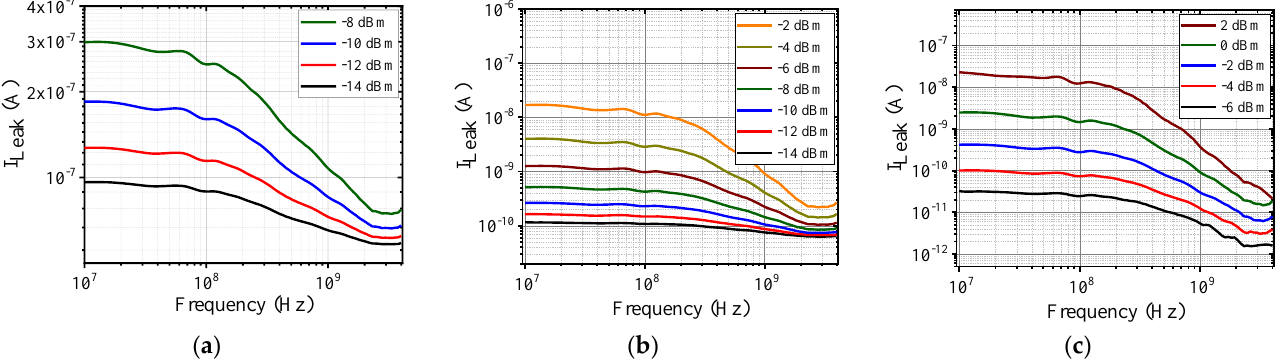
Figure 8. The measured leakage current due to a NMOS for a 1 × inverter fabricated in the ( a ) 65nm, ( b ) 130 nm, and ( c ) 180 nm standard CMOS technology node.